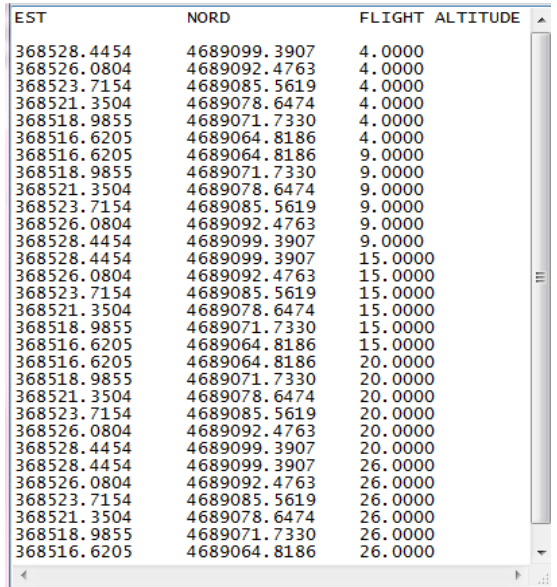
Figure 7. Waypoint coordinates calculated by the software UP23d